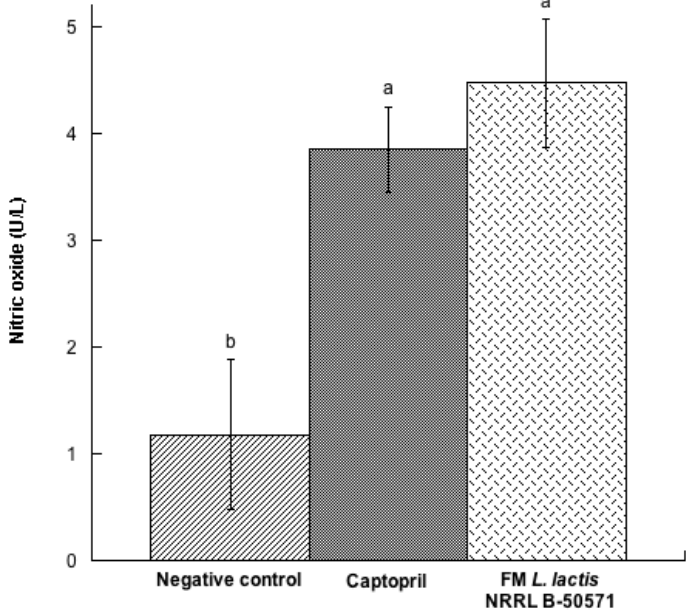
Figure 6. Nitric oxide (U/L) in plasma from spontaneously hypertensive rats after long-term treatments. Negative control: purified water; Captopril: 40 mg/kg body weight; FM L. lactis NRRL B-50571 (ad libitum): fermented milk with Lactococcus lactis NRRL B-50571. Data are presented as means ± SEM. Data sharing the same letter are not significantly different ( p > 0.05).